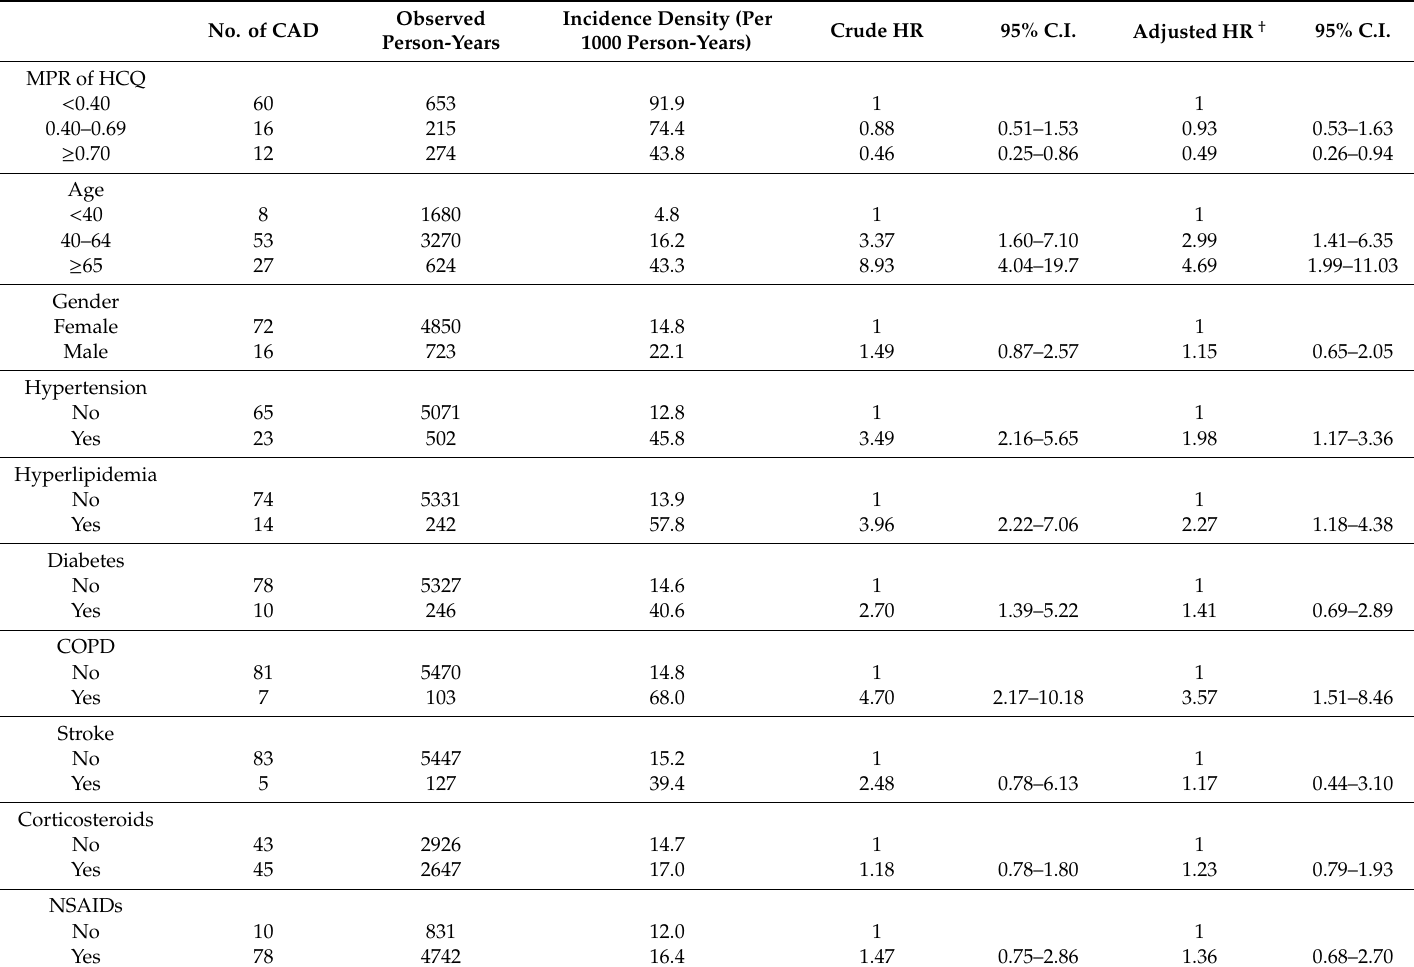
Table 2. The attack of coronary artery disease (CAD) in SS patients by di ff erent